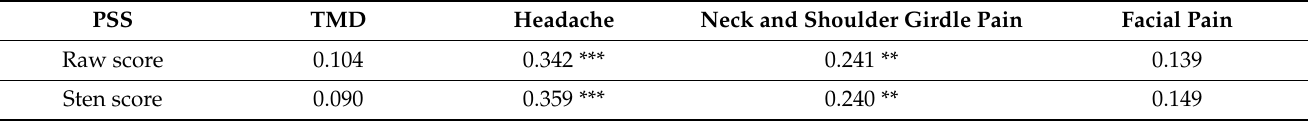
Table 3. Analysis of the correlation between the intensity of stress and the intensity of pain in the P1 group. PSS TMD Headache Neck and Shoulder Girdle Pain Facial Pain Raw score 0.104 0.342 *** 0.241 ** 0.139 Sten score 0.090 0.359 *** 0.240 ** 0.149